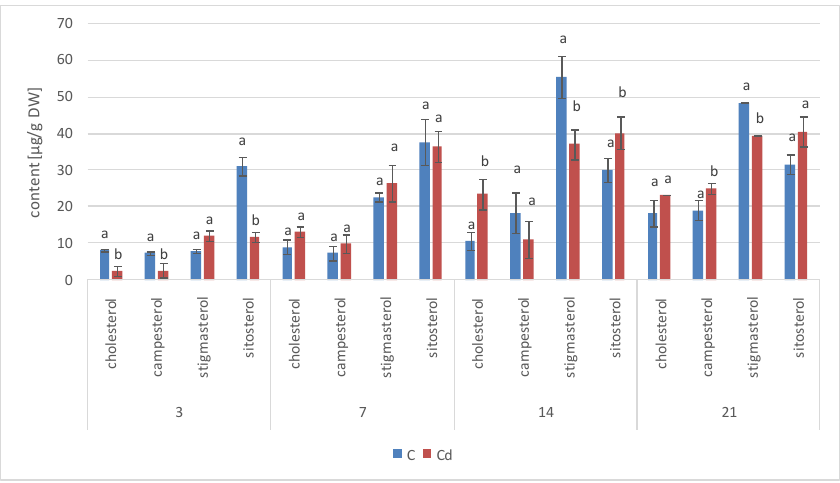
Figure 7. The effect of cadmium treatment on the content of sterol esters. Bars which do not share a common letter are significantly different ( p < 0.05).